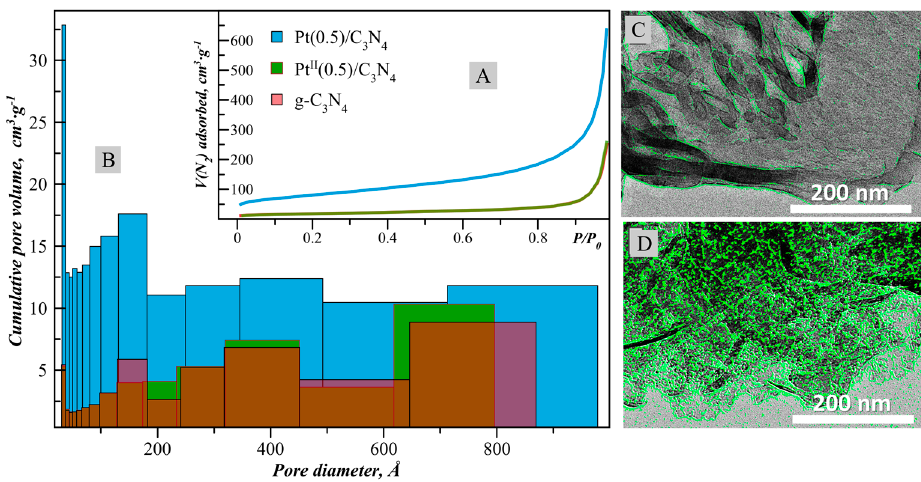
Figure 7. ( A ) Adsorption isotherms; ( B ) pore size distribution for g-C 3 N 4 , 0.5% Pt/g-C 3 N 4 (IV) without treatment and 0.5% Pt/g-C 3 N 4 (IV) after reduction in H 2 at 400 ◦ C. ( C ) TEM images of photocatalysts 0.5% Pt/g-C 3 N 4 (no treatment) and ( D ) 0.5% Pt/g-C 3 N 4 ( Т = 400 ◦ C). Reprinted with permission from Ref. [103]. 2022, Elsevier.